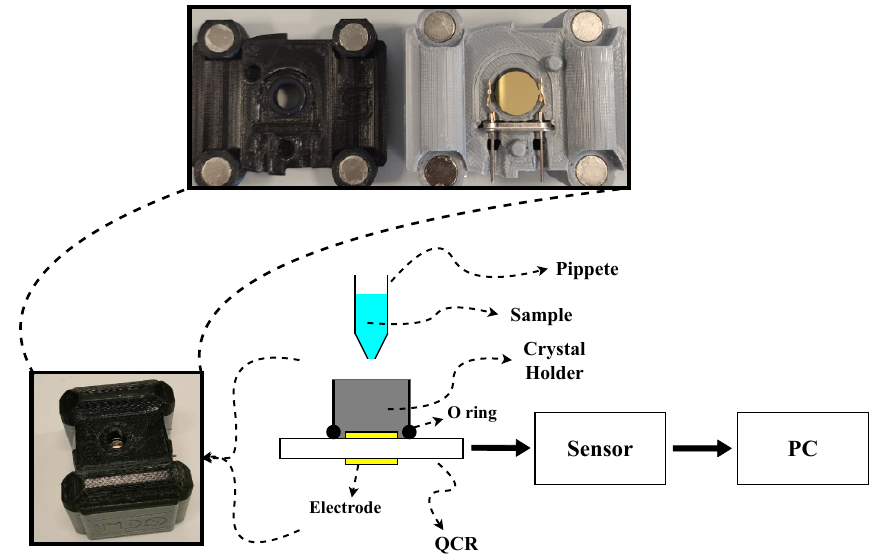
Figure 7. Experimental setup to measure hydrogel gelation process. AT-cut quartz crystals with f 0 = 10 MHz, gold electrodes, electrode dimensions of 5 and 11 mm, roughness < 1 nm, and mounted onto an HC-51 holder were used (Figure 7). The crystals were purchased from Krystaly (Hradec Králové, Czech Republic). After each experiment, the crystal was cleaned using a 2% solution of sodium dodecyl sulfate, and immersed in a mixture of 10 mL of water, 2 mL of ammonia, and 2 mL of hydrogen peroxide for 10 min at 70 ◦ C. Lastly, it was rinsed with distilled water and dried with